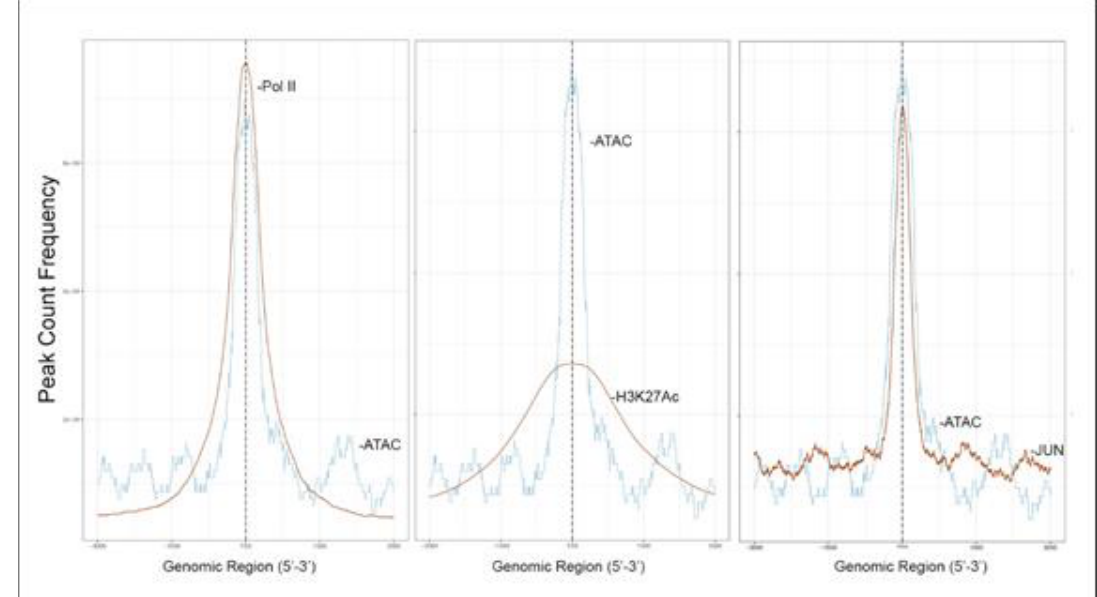
Figure 7. RSV-induced promoters are enriched in active histone marks and JUN/AP1 binding. Shown are transcription factor overlap plots of ATAC-seq signals with ChIP-seq binding of RNA Pol II, H3K27Ac, and JUN by Peak Count Frequency. Note the H3K27Ac binding is consistent with the broad domains produced by histone modification in contrast to the narrow peaks corresponding to polymerase and transcription factor binding.